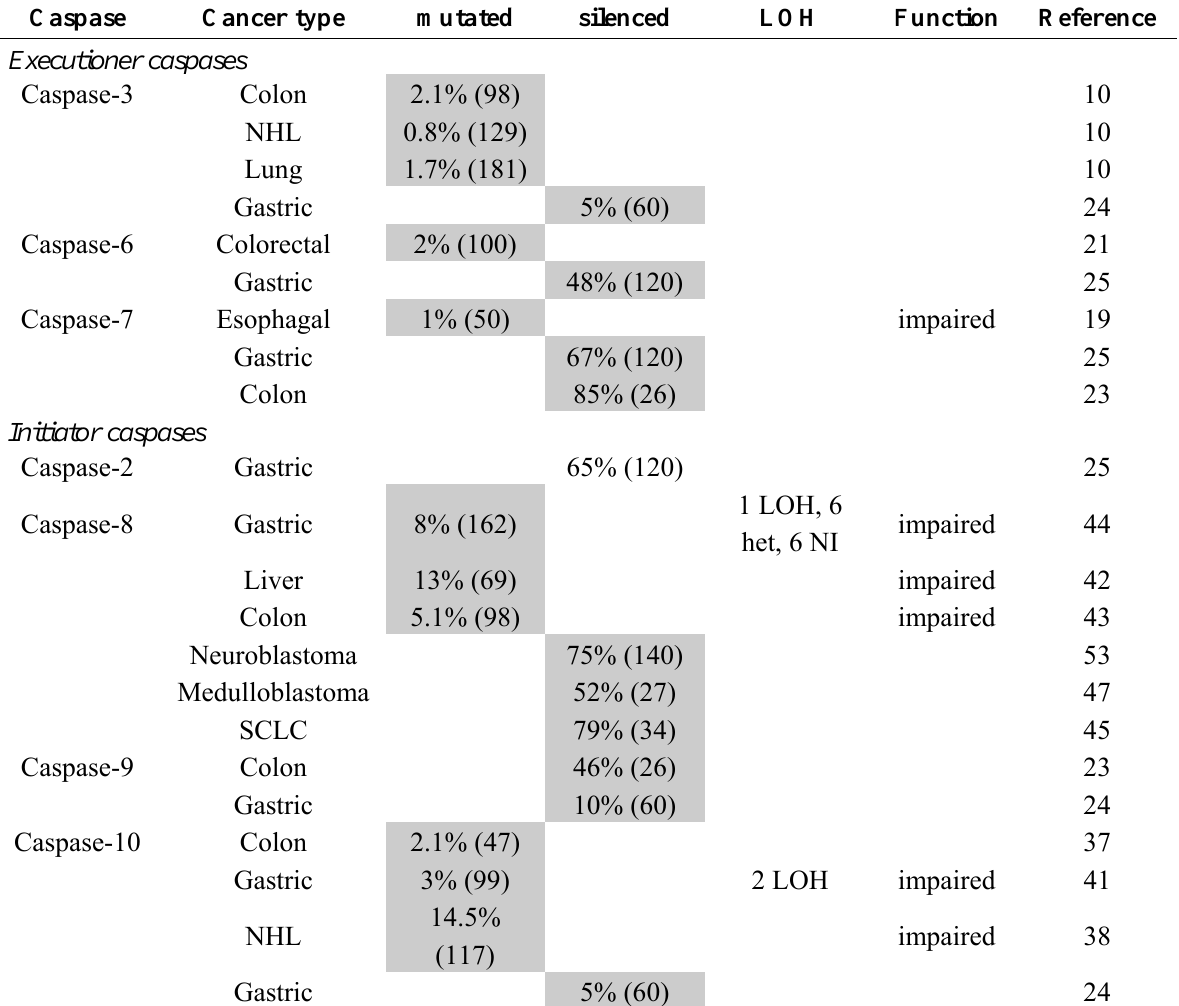
Table 1. Mutations and silencing of caspases in cancer. The percentages of cancer cases with non-silent mutations (missensse, nonsense or frameshift) or lack of expression ("silenced") of caspases are listed, respectively. Total numbers of cases examined are in brackets. Where available, information on number of tumor samples with loss of heterozygosity (LOH) or heterozygosity (het) of the mutant alleles is provided (NI: not informative), as well as information of the impact of the mutations on caspase